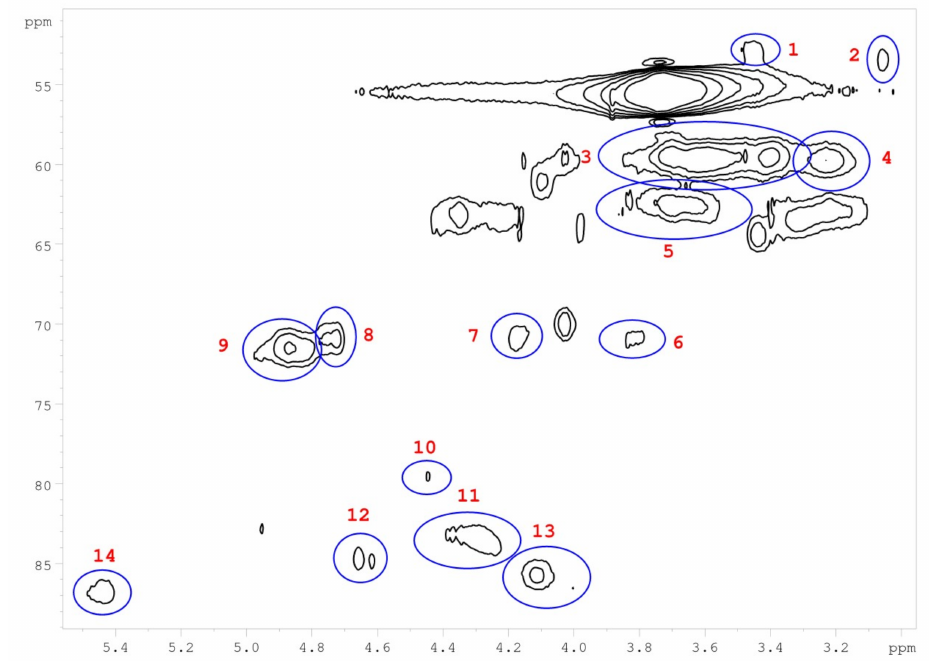
Figure 13. Non-aromatic HSQC region of a lignin obtained from M. x giganteus stem/leaf mixture (Gig17M). Numbers are listed and assigned in Table 9.